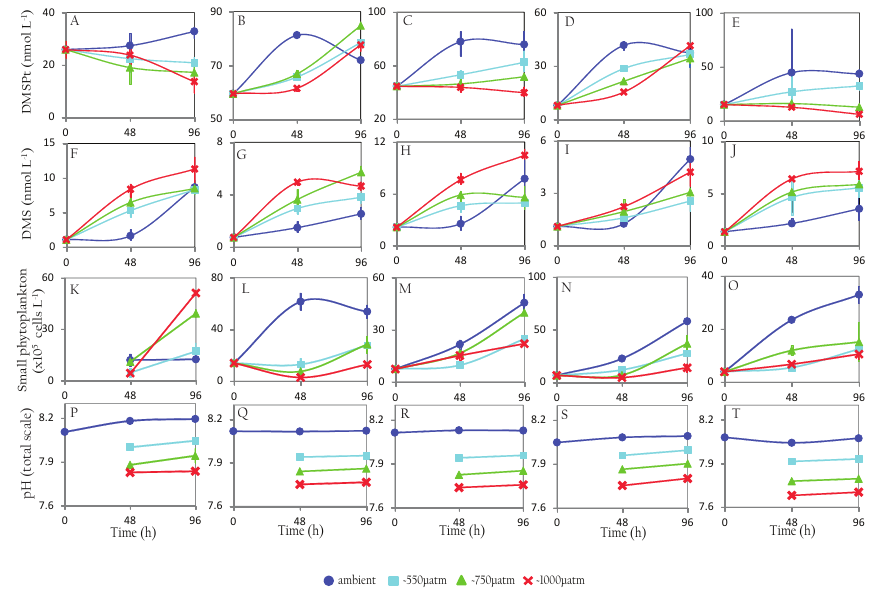
Figure 2. Concentrations (nmolL − 1 ) of total DMSP (a–e) and DMS (f–j) during five bioassay experiments; abundance of total small phytoplankton (<10µm) (k–o) ( × 10 5 cellsL − 1 ) and pH (total scale) (p–t) . See Table 1 for specific p CO 2 and pH for each experiment. Different scales are used on plots to ensure trends are visible. Values shown are means of experimental triplicates, and error bars indicate the standard error (SE). For pH measurements, SE generally fell within the bounds of the symbols used on the plots. Smoothed lines on plots do not represent extrapolation of data between time point measurements but are used to highlight